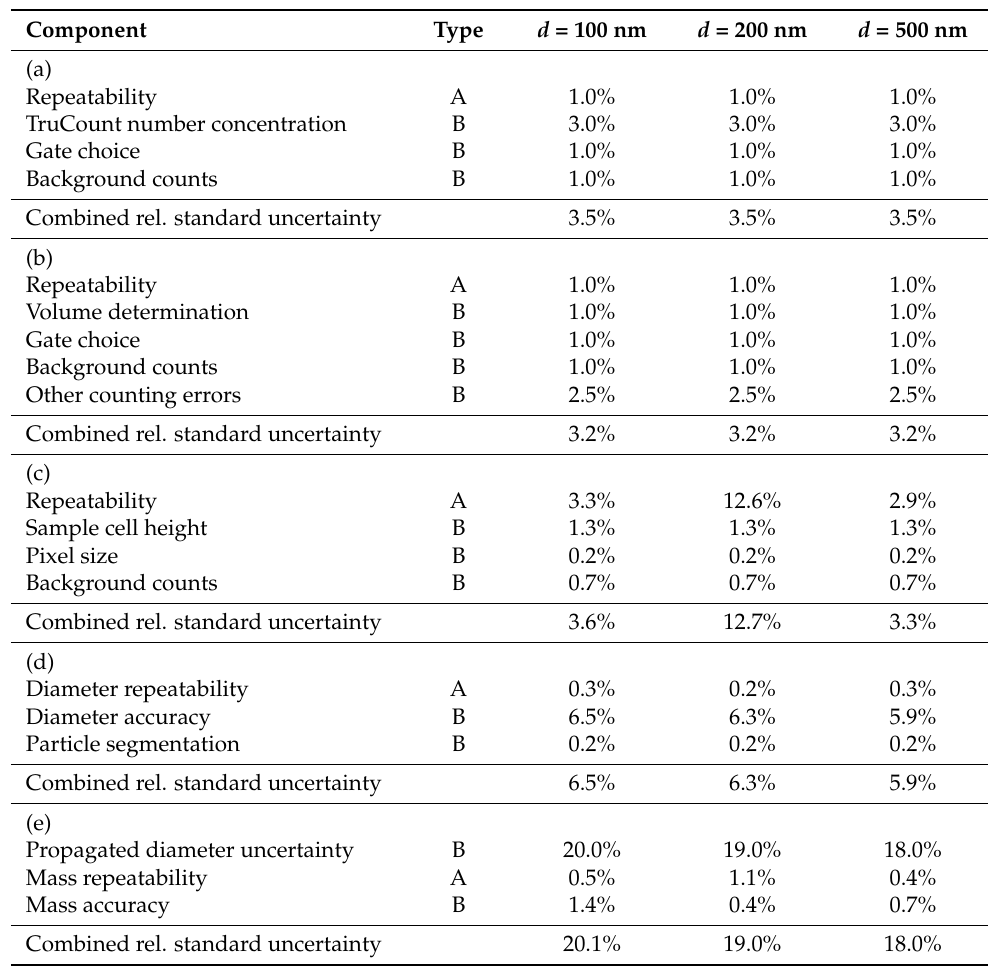
Table 2. Components of the relative standard ( k = 1) uncertainty in the measured number concentra- tion for each of the consensus techniques, (a) FCM—internal standard, (b) FCM—absolute